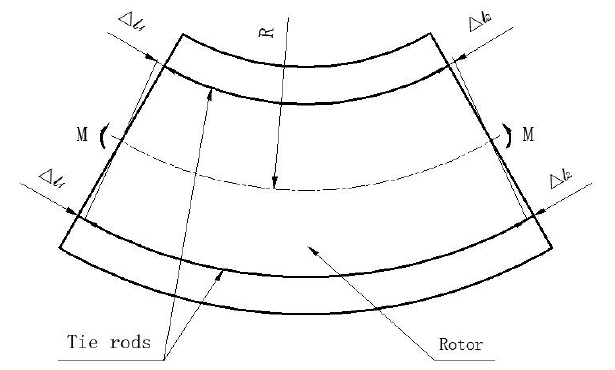
Figure 2. The coordinated deformation of tie rods .